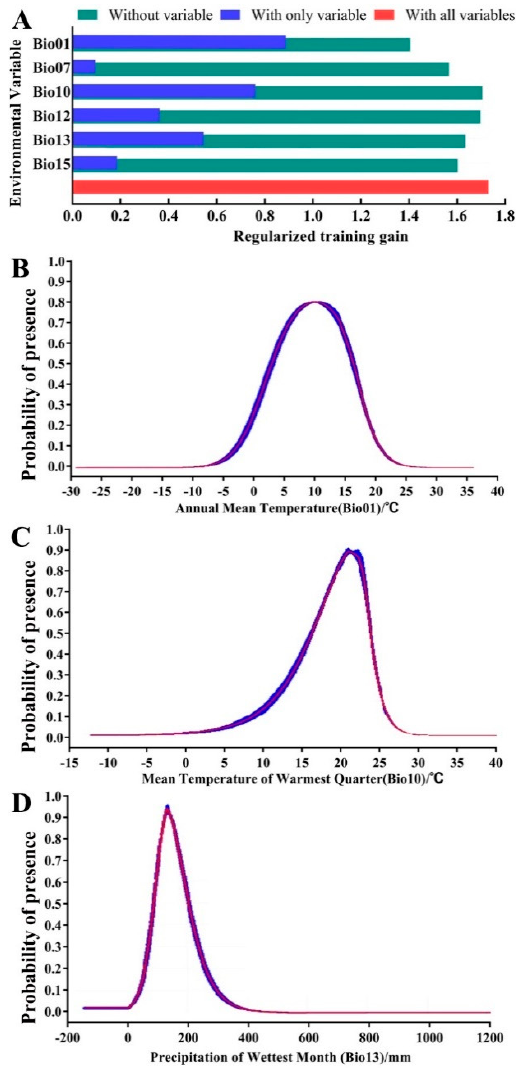
Figure 3. Jackknife test plot ( A ) and response curves of bioclimatic variables ( B – D ) that affect the distribution of S. noctilio. ( A ) “Without variable” represents the regularized training gain of the model without this variable, “With only variable” represents the regularized training gain of the model with only this variable, “With all variable” represents the regularized training gain of the model with all variable, ( B ) Response curve of annual mean temperature (bio01), ( C ) Response curve of mean temperature of the warmest quarter (bio10), ( D ) Response curve of precipitation of the wettest month